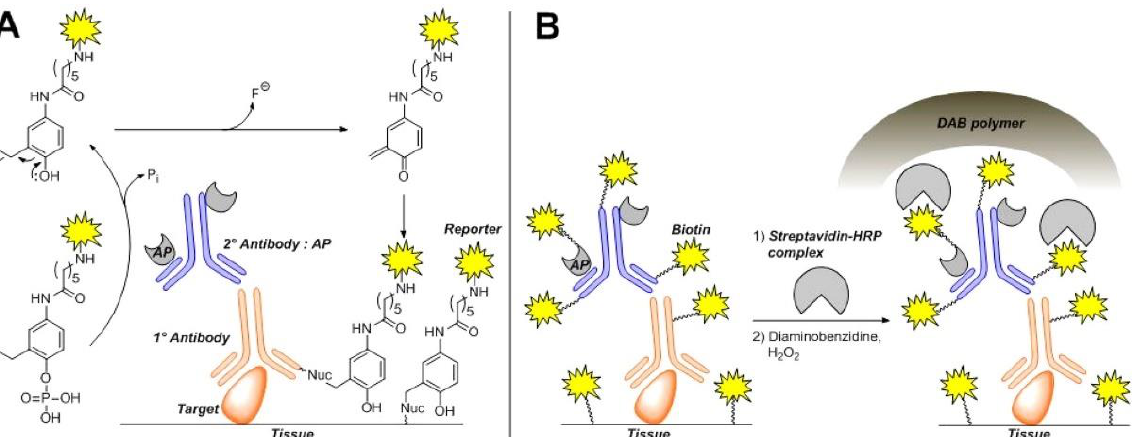
Figure 4. ( A ) Mechanism of covalent ligation to the target protein complex and ( B ) visualization of biotinylated probes with 3, 3′ -diaminobenzidine (DAB). Reprinted with permission from [36], copy- of biotinylated probes with 3,3 (cid:48) -diaminobenzidine (DAB). Reprinted with permission from [36], right 2016 American Chemical Society. copyright 2016 American Chemical